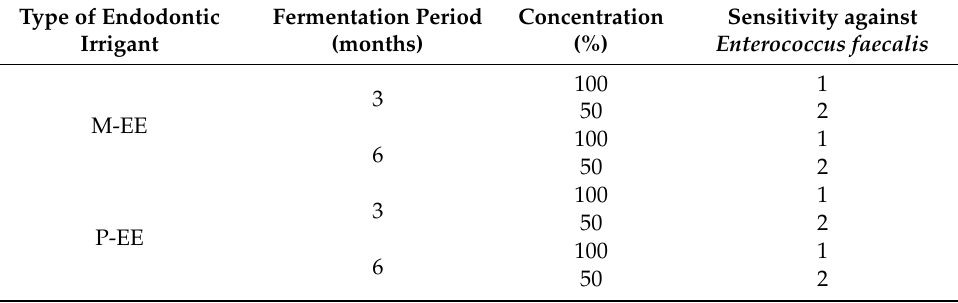
Table 3. Sensitivity against Enterococcus faecalis of M-EE and P-EE fermented for 3 and 6 months at 50% and 100% concentrations.